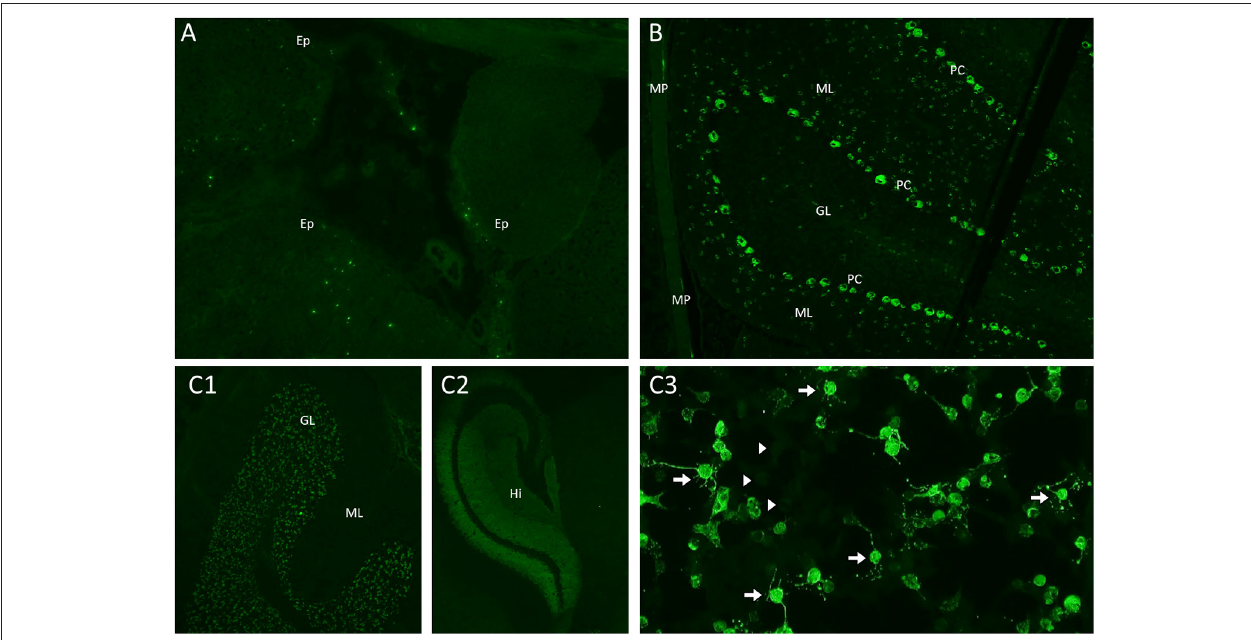
FIGURE 3 | Mouse brain, gut, and kidney tissue immunofluorescence and cell-based assay assessment for neural autoantibodies. (A) Kelch-like-protein-11 autoantibodies are identified using a mouse tissue composite with immunofluorescence to identify the characteristic peri-ependymal (Ep) sparkles of immunostaining; (B) Purkinje-cell-autoantibody-type 1 (PCA-1/anti-Yo) antibodies are identified using a mouse tissue composite with immunofluorescence staining in the characteristic pattern with staining purkinje cells (PC), additional cells in the molecular layer (ML) of the cerebellum and the myenteric plexus (MP); (C) N-methyl-D-aspartate (NMDA) receptor antibodies are identified using a mouse tissue composite with the characteristic pattern of immunostaining involving the granular layer (GL) (C1) and hippocampus (Hi) (C2) ; A confirmatory cell-based assay reveals characteristic immunostaining of cells transected with the NMDA receptor [ (C3) , arrows] in comparison to non-transfected cells [ (C3) ,